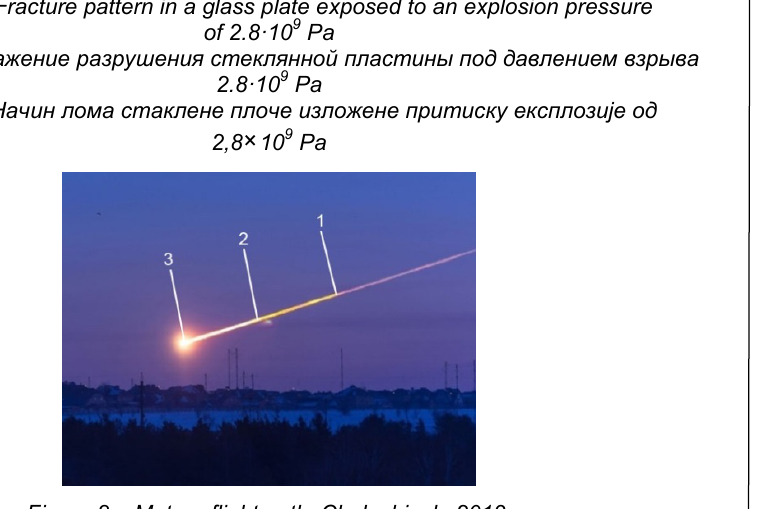
Figure 8 – Meteor flight path, Chelyabinsk,